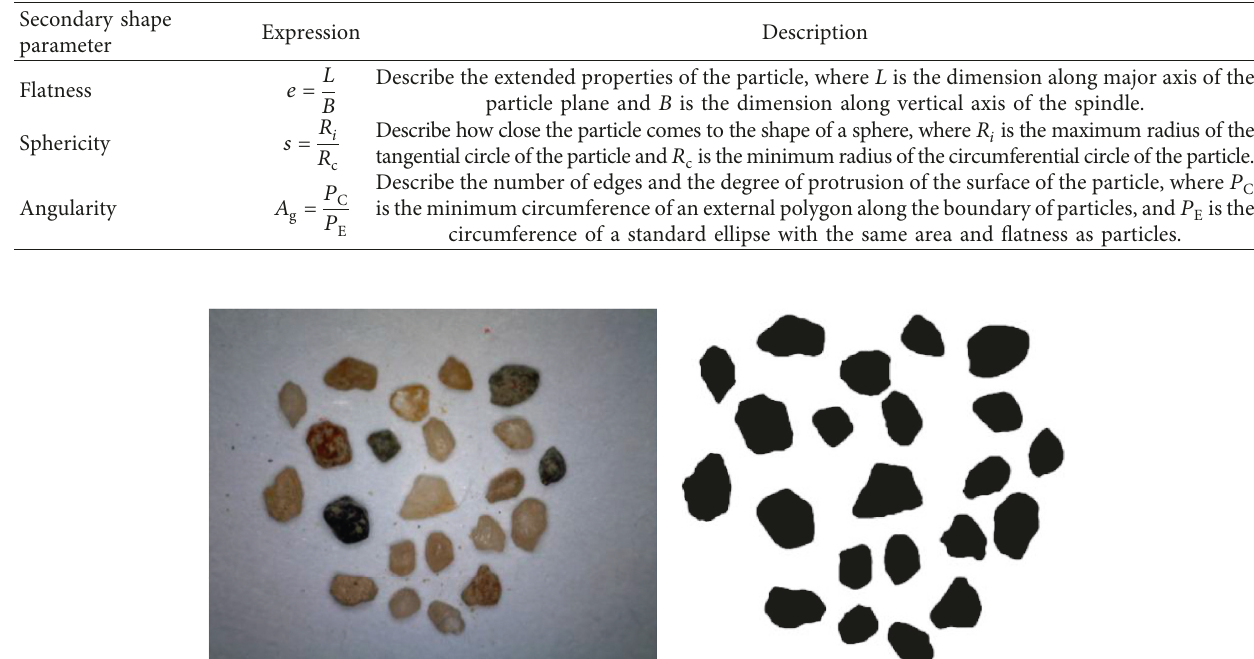
Table 2: The expressions and descriptions of the secondary shape